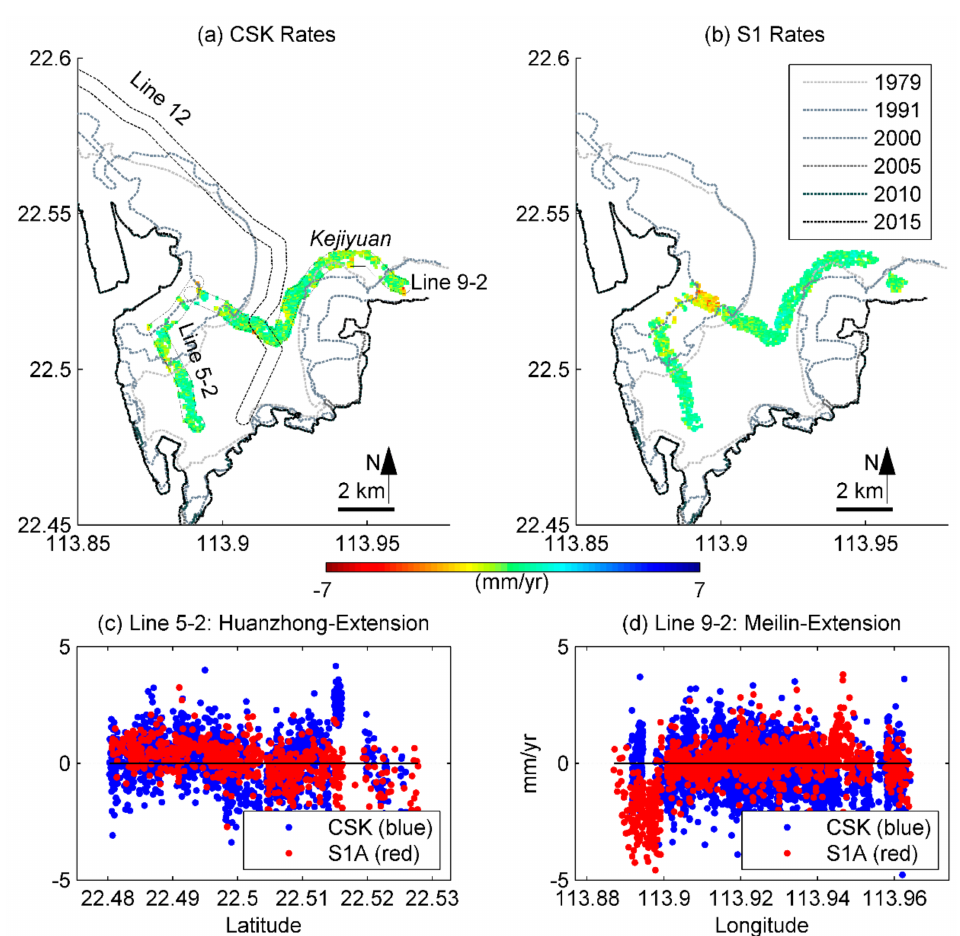
Figure 14. ( a ) Mean rates along subways in Shenzhen from CSK with buffer distance of 250 m to both sides of Section 2 of Line 5 and Section 2 of Line 9; ( b ) Is the same for S1; ( c ) Mean rates along Section 2 of Line 5 from CSK and S1 with buffer distance of 250 m to both sides of the subway; ( d ) Is the same for Section 2 of Line